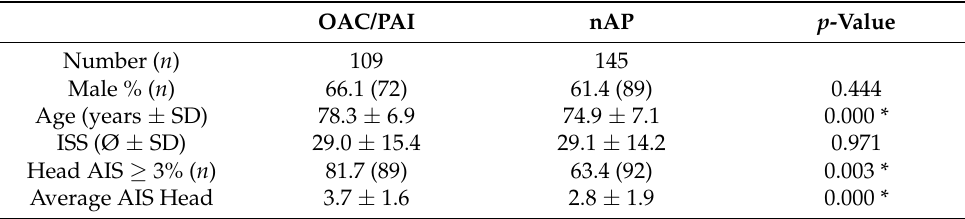
Table 1. Demographic data of analyzed patients. OAC/PAI nAP p